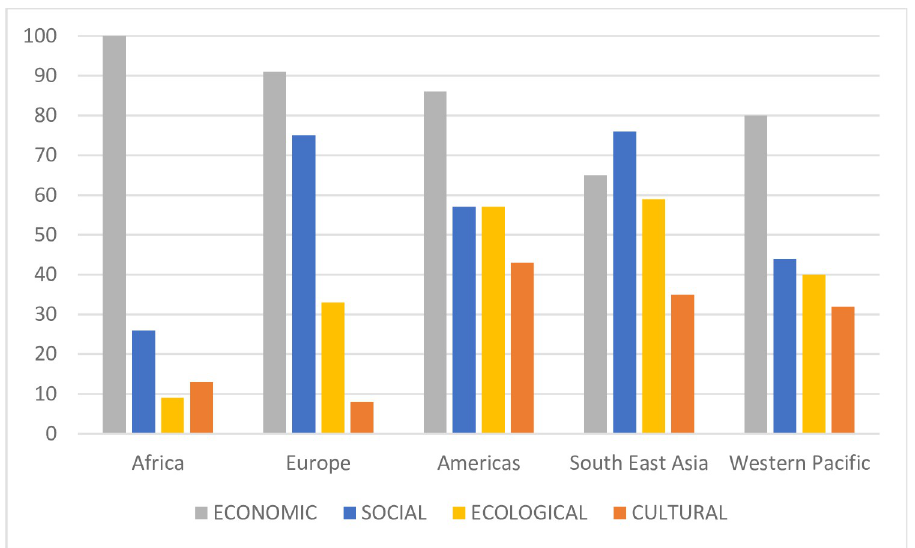
Fig 3. The proportion of studies that investigated the four main determinants of health and wellbeing (social, cultural, economic and ecological) in each region.